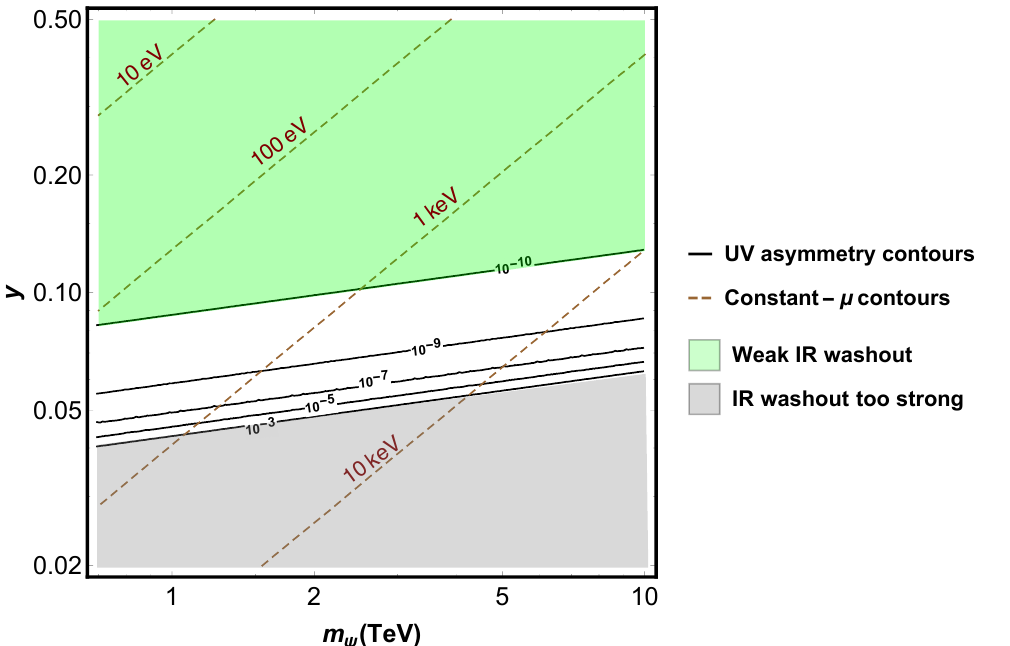
Figure 3 . Contours of needed UV asymmetry (solid black lines) and (cid:22) (dashed brown lines) in the ( m (cid:9) ; y ) plane to obtain the observed baryon asymmetry Y (cid:1) B 10 (cid:0) 10 and m (cid:23) = 0 : 05 eV. (cid:24) In the green shaded region, washout at the TeV scale is negligible so that the UV asymmetry needs to be the observed baryon asymmetry 10 (cid:0) 10 . On the other hand, for smaller values of (cid:24) y , due to exponential sensitivity in y and m (cid:9) , UV asymmetry lines get closer to each other. In the gray shaded region, TeV scale washout becomes so large that even saturating maximal